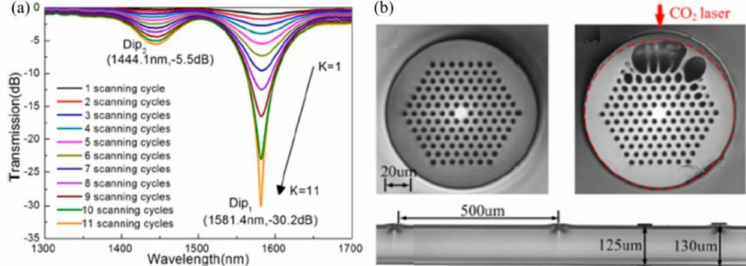
Figure 7. ( a ) Transmission spectrum evolution of a CO 2 -laser-heated inflated SLPFG (I-SLPFG) in a solid-core PCF while the number of scanning cycles increases; ( b ) microscope images of the I-SLPFG with periodic inflations [29,48].